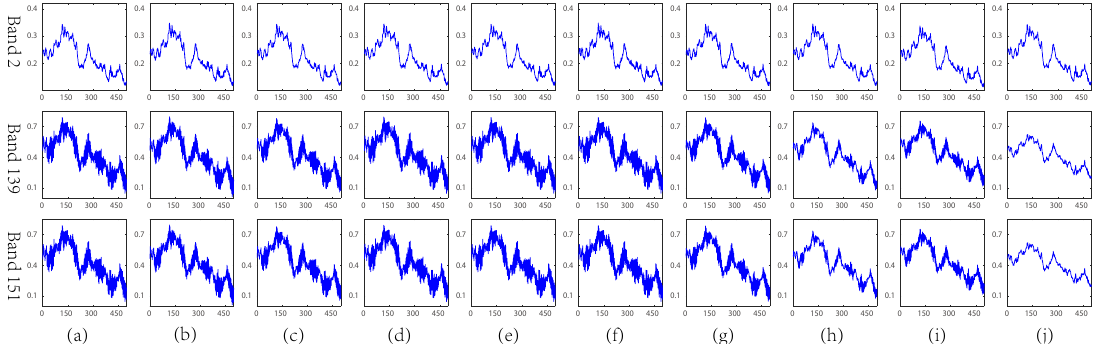
Figure 10. From top to bottom: restoration results of bands 2, 139 and 151 of the real Terrain HSI dataset. ( a ) Original HSI; ( b ) SVD; ( c ) BM4D; ( d ) TDL; ( e ) WNNM; ( f ) WSNM; ( g ) LRMR; ( h ) LRTV; ( i ) NMoG; ( j ) DP-GMM.